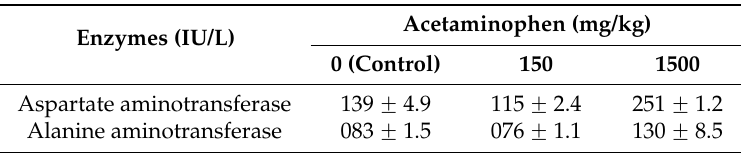
Table 1. AST and ALT activity of experimental group of